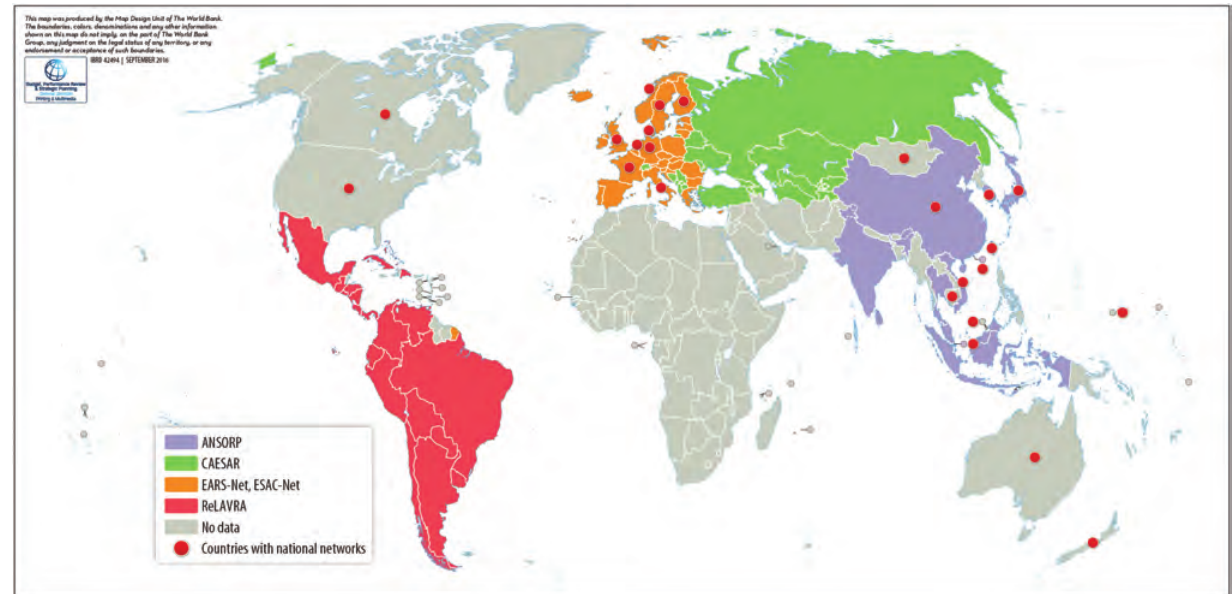
FIGURE 12. Global AMR Surveillance